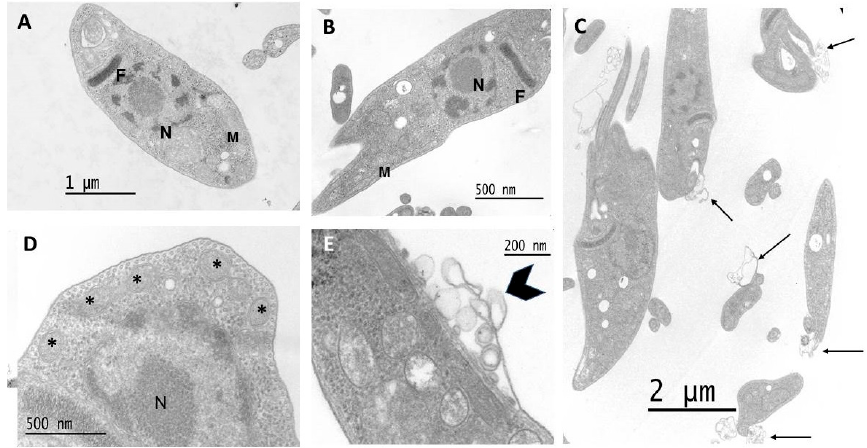
Figure 8. ( A , B ) Untreated parasites displayed typical morphology. M, mitochondrion; K, kinetoplast; N, nucleus. ( C ) Epimastigotes treated for 48 h with 12 µM of santhemoidin C induced a plasma membrane shedding (black arrows). ( D ) Parasites treated with 18 µM for 48 h displayed the formation of cytoplasmic vacuoles, which resemble autophagosomes (asterisks) and ( E ) a detachment of plasma membrane (arrowhead).